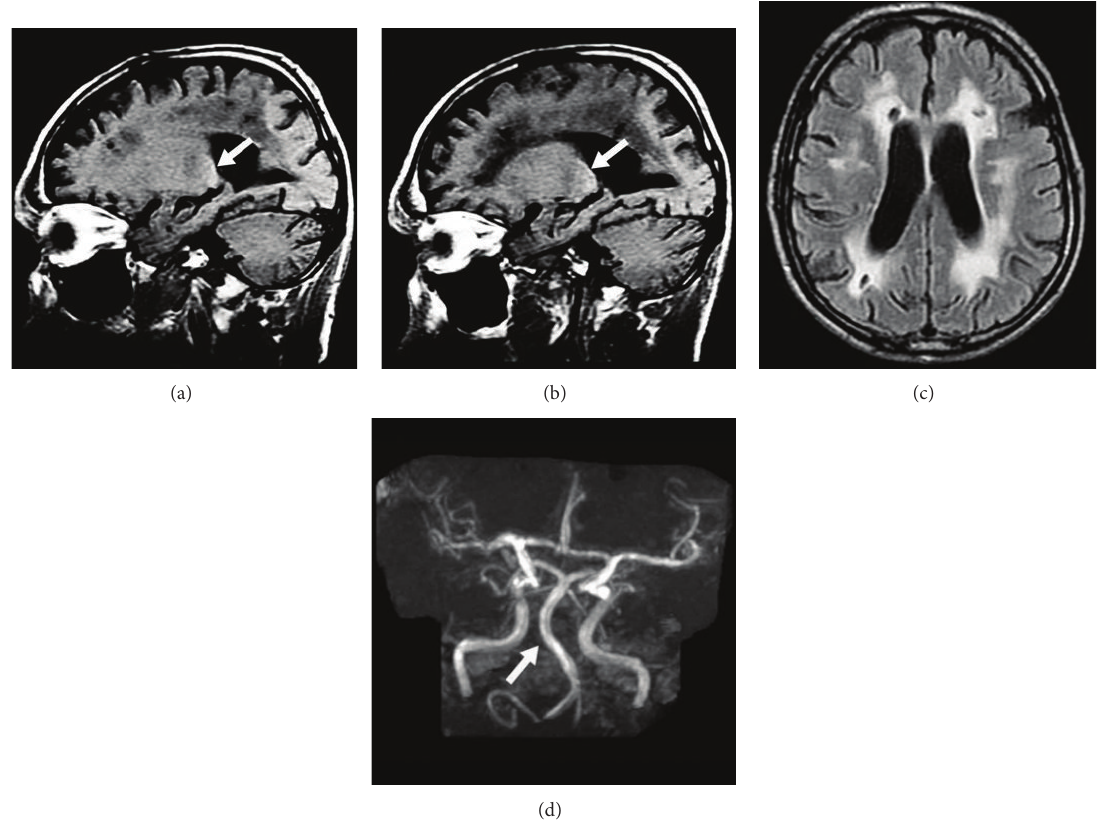
Figure 10: Sagittal unenhanced T1-weighted imaging (a and b) in a Fabry patient showing hyperintensity in the pulvinar, associated with ischemic leukoencephalopathy on FLAIR sequences (c) and vertebrobasilar dolichoectasia on TOF imaging (d).